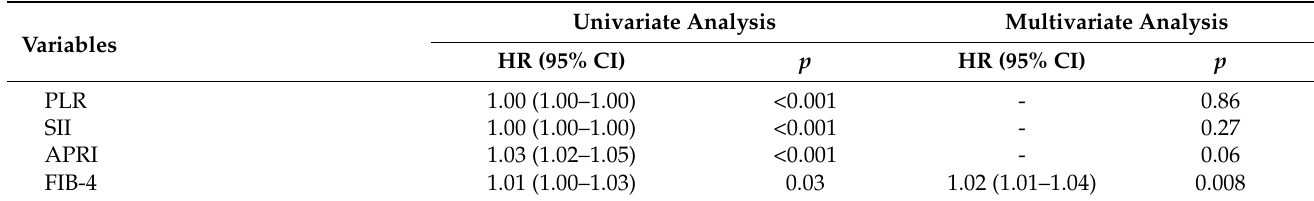
high FIB-4 and NLR. The median TTP for groups 1, 2, and 3 was 7.1, 3.0, and 2.4 months, respectively, and 1-year progression rates for groups 1, 2, and 3 were 64.4%, 82.5%, and 91.6%, respectively (Figure 1a). As compared with group 1, group 2 had a 1.5-fold (HR, 1.53; 95% CI, 1.14–2.05; p = 0.004) increased risk of progression after TACE, and group 3 had